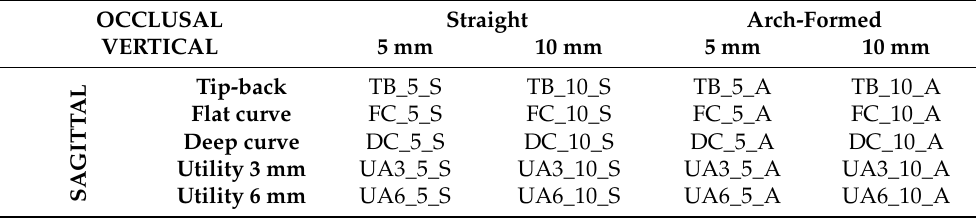
Figure 3. Arch-formed configurations in the occlusal view. Table 1. Overview of the cantilever designs.